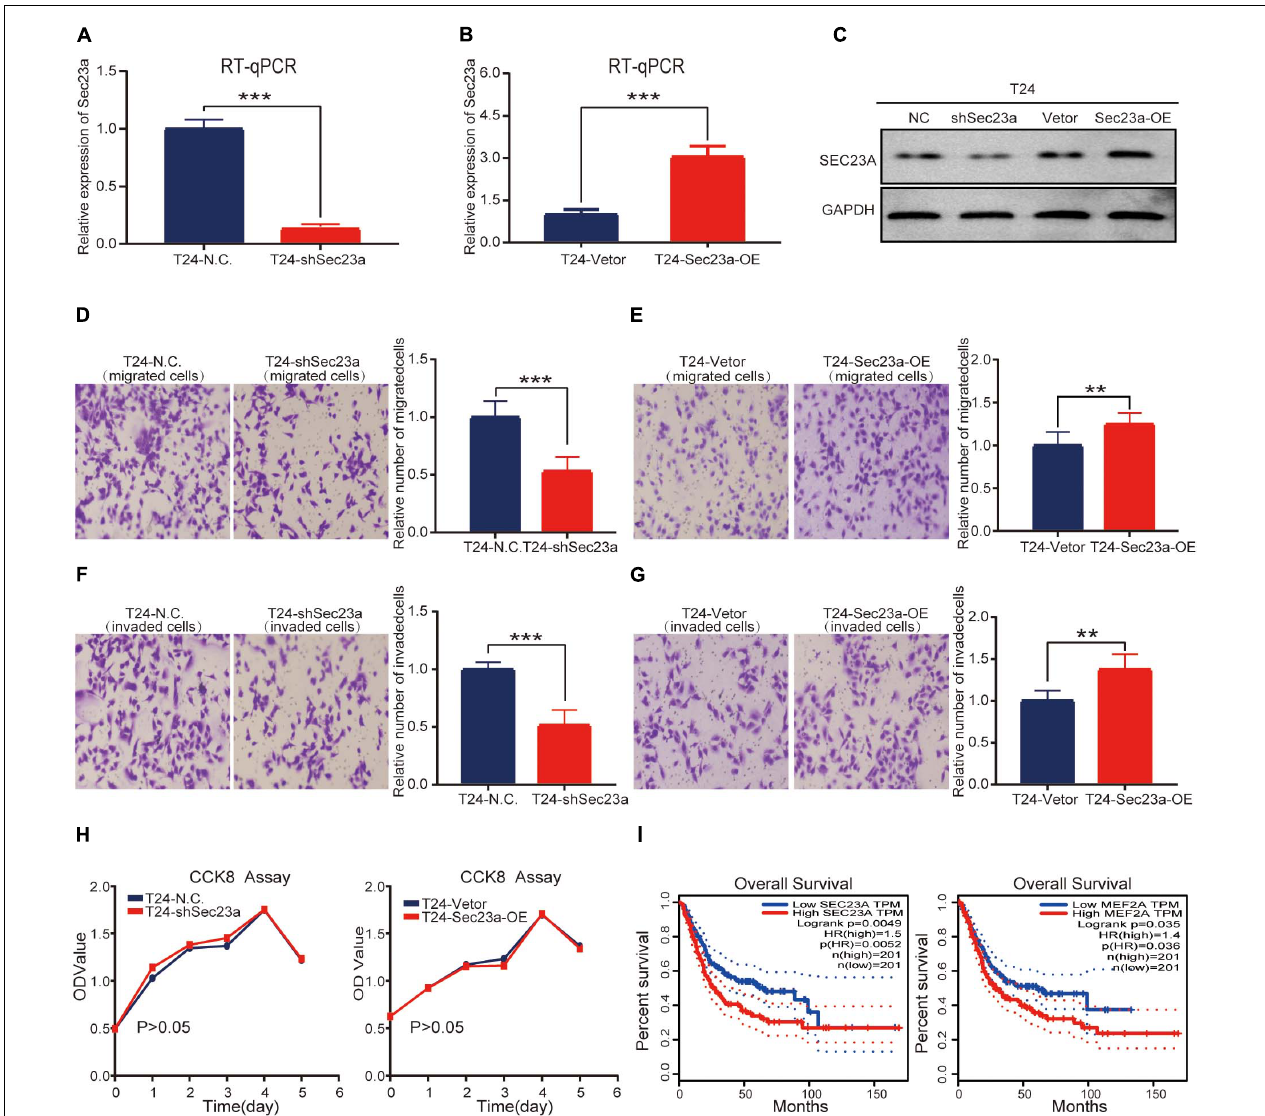
FIGURE 5 | SEC23A expression effectively augments the metastatic capacities of T24 in vitro . (A) RT-PCR measurement of mRNA expression of SEC23A in T24 and T24-shSEC23A cells; (B) RT-PCR measurement of mRNA expression of SEC23A in T24 and T24-SEC23A-OE cells. (C) Western-blotting analysis of SEC23A in T24, T24-shSEC23A, T24-vetor, and T24-SEC23A-OE cells. (D) Transwell migration assay of T24 and T24-shSEC23A cells (*** p < 0.001). (E) Transwell migration assay of T24 and T24-SEC23A-OE cells (** p < 0.01); (F) Transwell invasion assay of T24 and T24-shSEC23A cells, (*** p < 0.001). (G) Transwell invasion assay of T24 and T24-SEC23A-OE cells, (** p < 0.01). (H) Proliferation activities of T24 vs T24-shSEC23A and T24 vs T24-SEC23A-OE were measured by the CCK-8 assay. (I) Survival analysis of SEC23A and MEF2A by